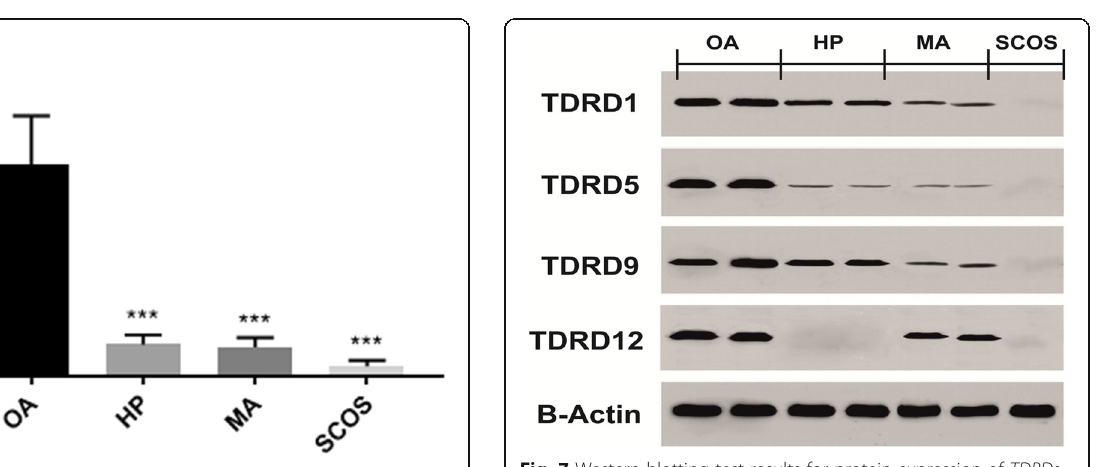
Fig. 7 Western blotting test results for protein expression of TDRDs genes in HP, MA, SCOS, and OA samples compared to control group